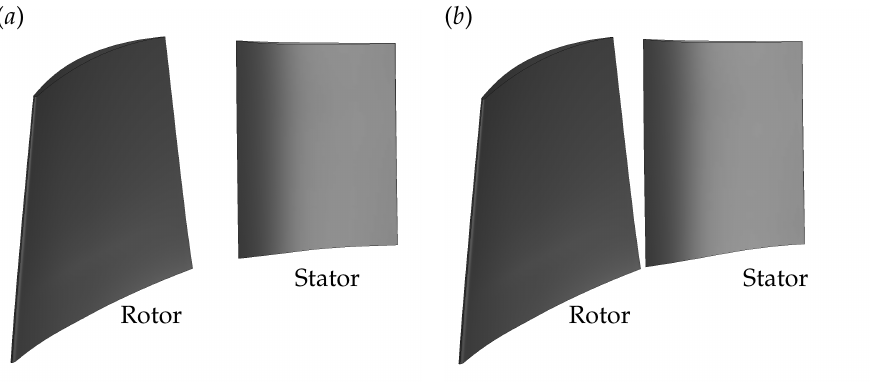
Figure 9. The relative positions of the rotor and the stator at: ( a ) g = d 0 and ( b ) g = 10% d 0 .